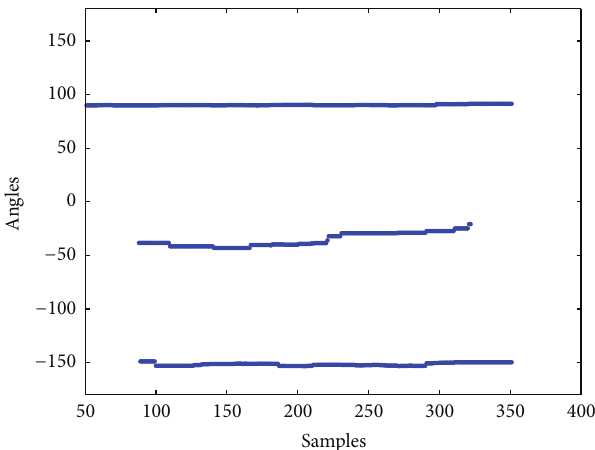
Figure 6: DOAs for three speakers at 90 , −30 , and −150 degrees.